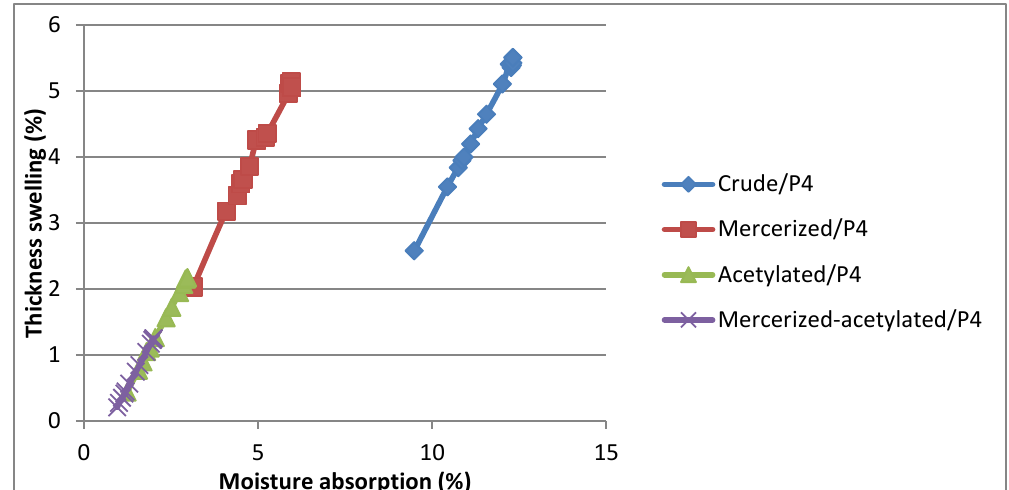
Fig. 16. Moisture absorption versus thickness swelling for P4 fibre contents among various fibre